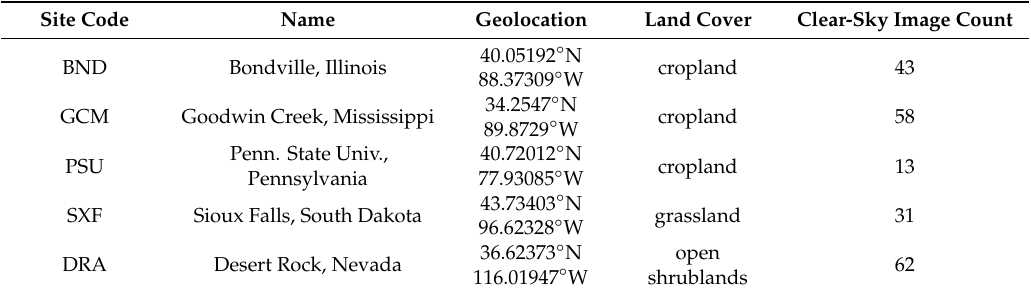
Table 3. The information of the surface radiation budget network (SURFRAD) sites and the image numbers under clear-sky